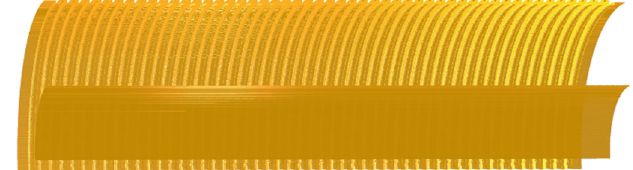
FIG. 3. An example of the geometries for grooved coaxial lines used in this simulation by GDFIDL . This shows the case for a pitch of 2.0 mm and a depth of 1.4 mm.